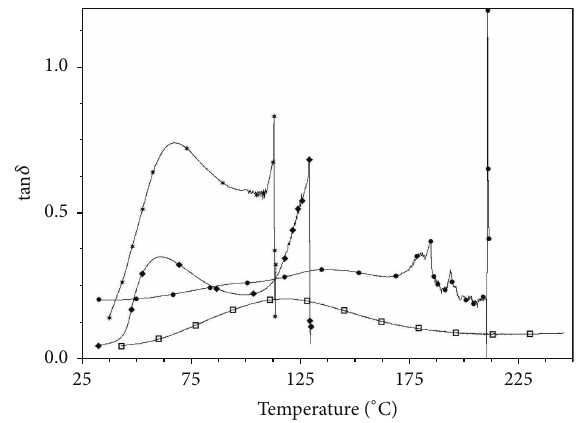
Figure 4: Mechanical relaxation temperature and loss factor of unaged fills: ( e ) Klucel G/CaCO 3 , ( X ) PB72/ 𝜇 phenolic balls, (∗) PB72/ 𝜇 glass beads, and ( ◻ ) kuro-nakanuri lacquer.